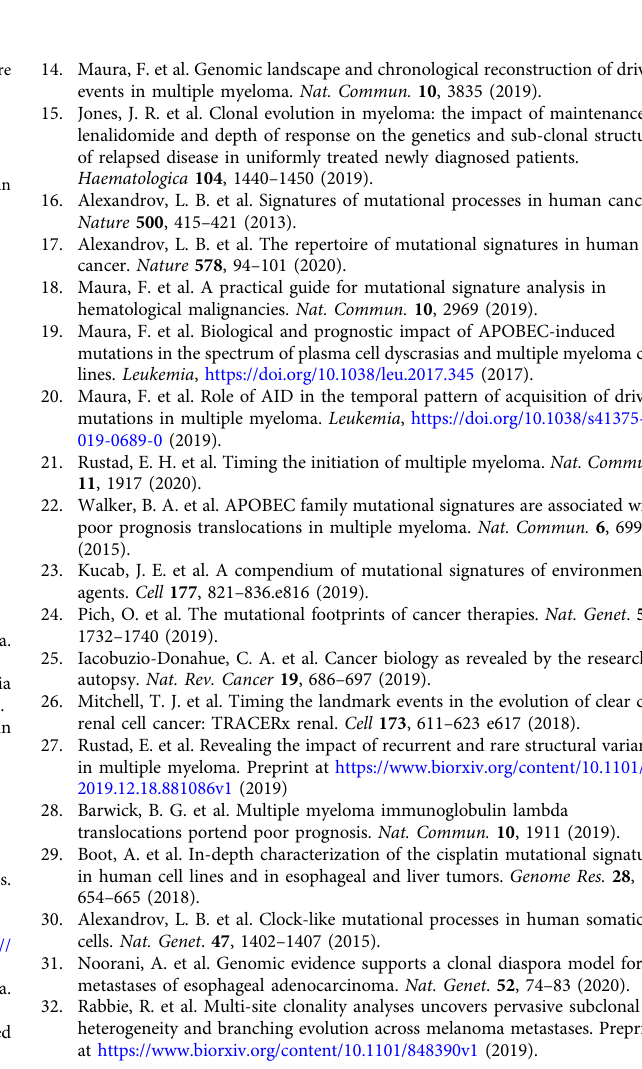
Fig. 8 Early versus late divergence of disease sites. a SBS1 is a mutational signature re fl ective of biological cell aging. By estimating changes in SBS1 in the trunk and the branches, we were able to study the speed of the tumor evolution in a given site at a given time-point. Here, we show the difference in SBS1 branch:trunk ratio between newly diagnosed and relapsed multiple myeloma ( p -value estimated using Wilcoxon tests). A lower SBS1 branch:trunk ratio represents a highly accelerated evolution since divergence from the trunk (the most recent common ancestor). Boxplots show the median and interquartile range; observations outside this interval are shown as dots. b A schema summarizing the seeding patterns over time, starting as slow seeding and tumor growth during the precursor phase, with acceleration in advanced